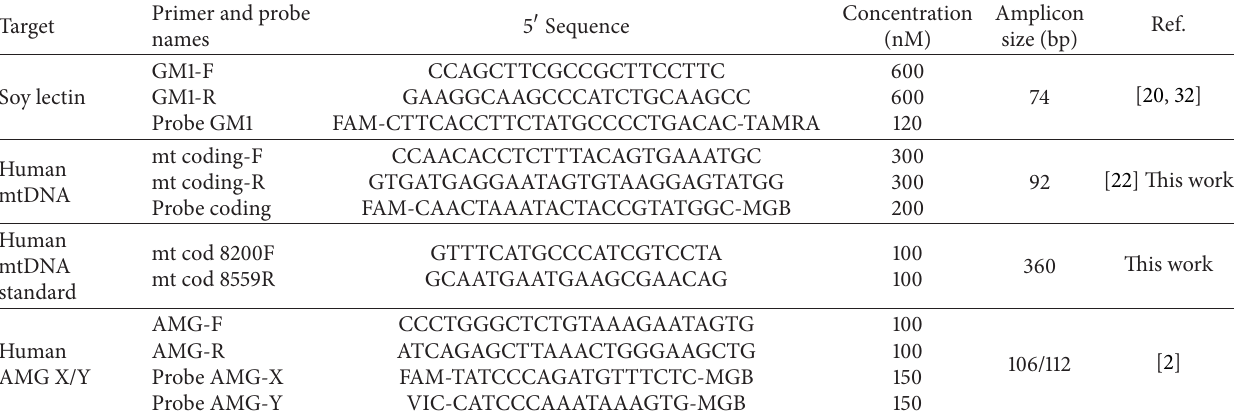
Table 1: List of primers and probes. For each target name, sequence, concentration used, amplicon size, and reference are shown.